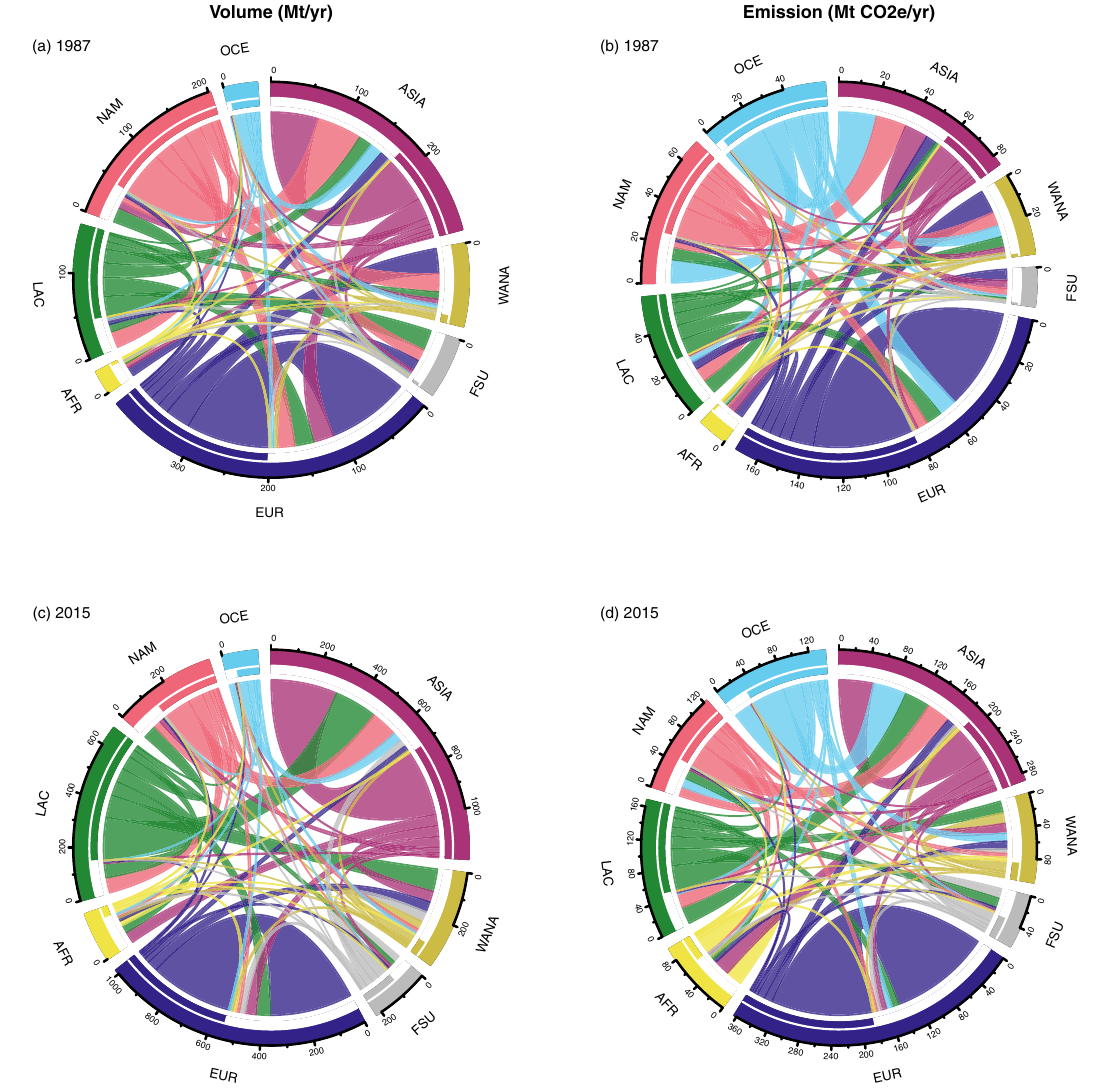
Fig. 4 Inter- and intra-regional trade fl ows in 1987 and 2015. Trade fl ows in terms of volumes (Mt) are shown on the left ( a , c ), while trade fl ows in terms of embodied emissions (Mt CO 2e /yr) are shown on the right ( b , d ). The fi rst coloured bar from the outside of each circle represents the sum of both exports and imports, whereas the second coloured bar indicates exports from the region ’ s countries. Colours of the trade fl ows correspond to the exporting region. The regions analysed are Africa (AFR), Western Asia and Northern Africa (WANA), Asia (ASIA), Europe (EUR), Former Soviet Union (FSU), Latin America and the Caribbean (LAC), North America (NAM), and Oceania